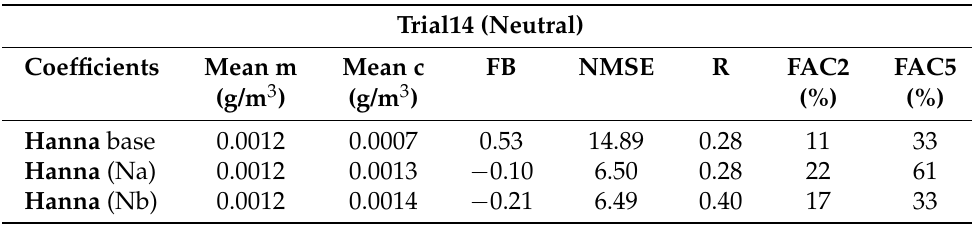
Table 2. Statistical analysis for the mean concentrations in the neutral case trial 14. m indicates measured and c calculated.